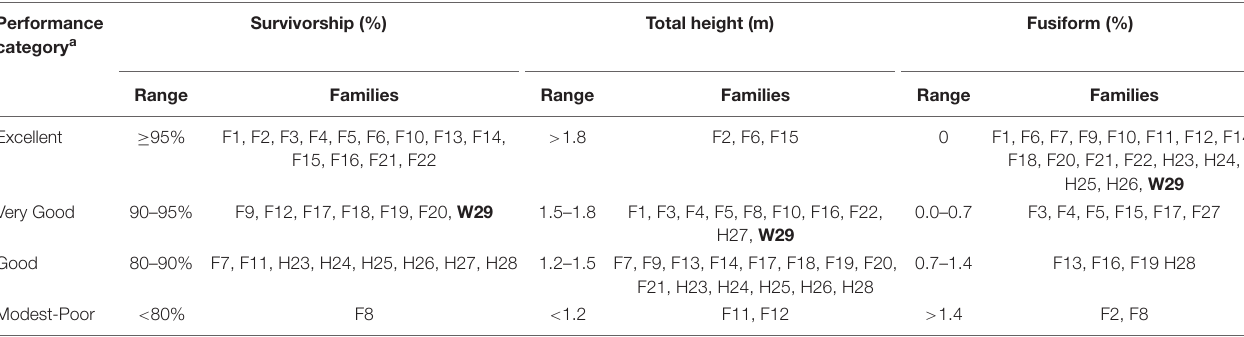
TABLE 5 | Relative ranking of family performance in 1972 using arbitrary categories, with the Crossett woods-run family (W29) highlighted in bold. Performance category a